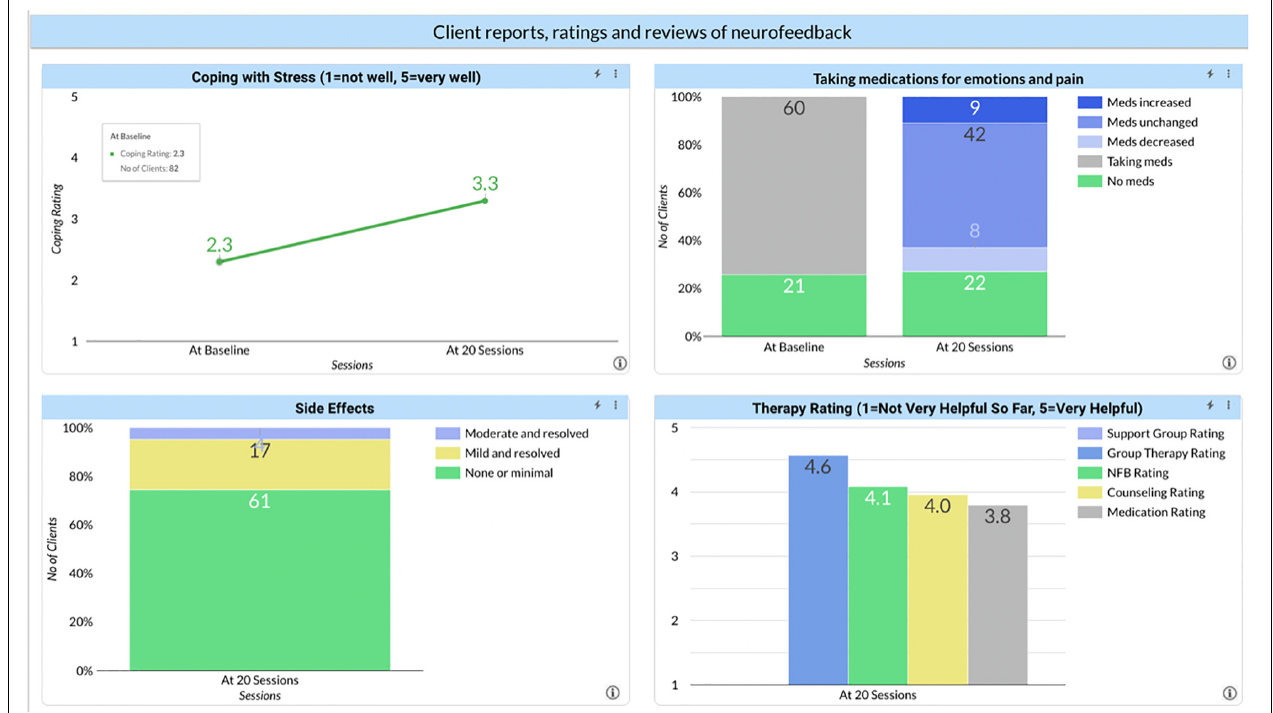
FIGURE 5 | Client reports, ratings, and reviews of neurofeedback. Reported outcomes from clients at baseline and after 20 neurofeedback sessions for: coping with stress, taking medications for emotions and pain, side effects, and the helpfulness of